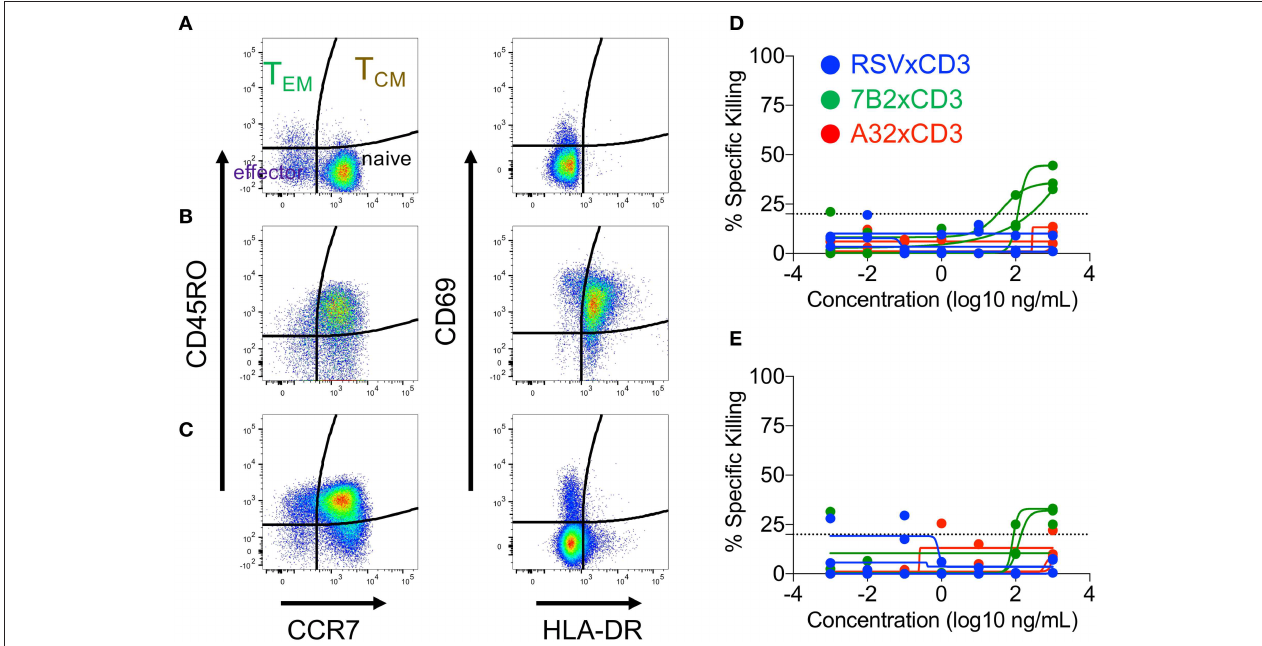
FIGURE 4 | Cord blood mononuclear cell (CBMC) CD8 + T cells subset distribution (left panels) and activation state (right panels) after (A) overnight rest, (B) 3 days of T cell receptor stimulation (anti-CD3, anti-CD28, and IL-2), or (C) 3 day transition from activated cells back to the resting state. Representative example shown. Similar levels of DART molecule-redirected killing of autologous HIV-1 4403bmC5-infeced CD4 + T cells were observed in assays performed with (D) CD8 + T cell effectors after overnight rest, and (E) as they returned back to a resting state following 3 days of T cell receptor stimulation. (D,E) represent data from 24h killing assays with a CD8 + effector to HIV-1 4403bmC5-infected autologous CD4 + target cell ratio of 30:1, performed using three different CBMC donors, each represented by individual